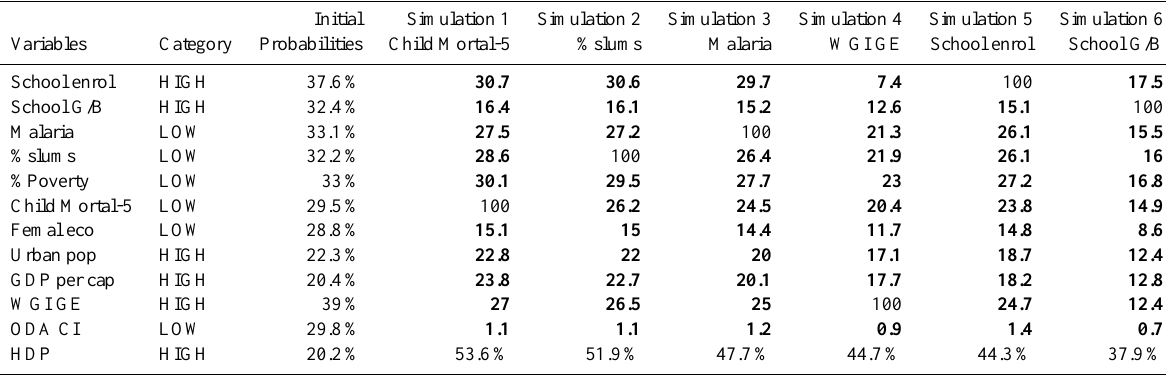
Table 4. Thematic model-HDP Simulations. In bold, the positive variations of